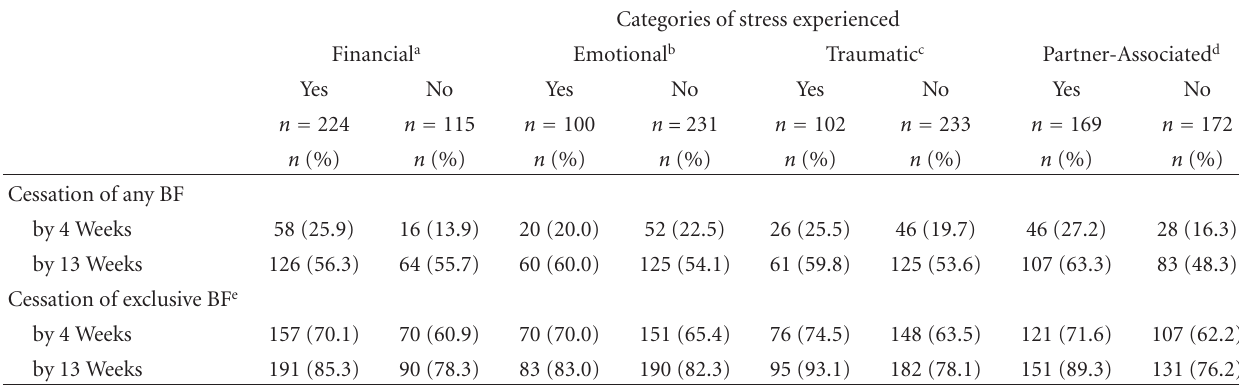
Table 2: Breastfeeding cessation outcomes across maternal stress categories ( n =